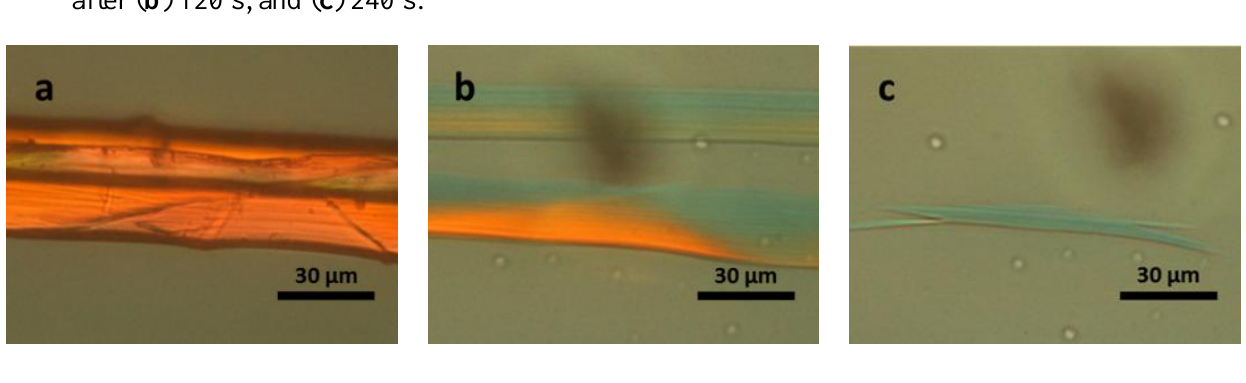
O ) pretreated wool fibre dissolving in 2 2